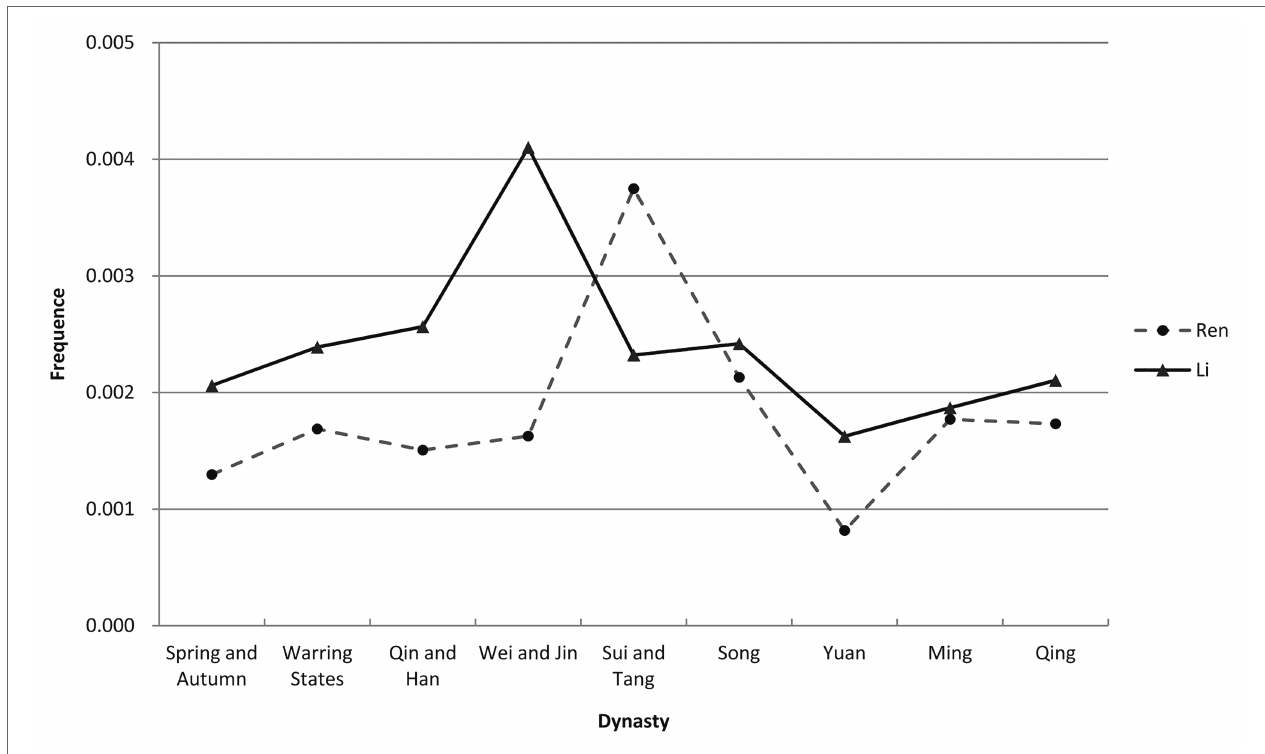
FIGURE 1 | The evolution of “Ren” and